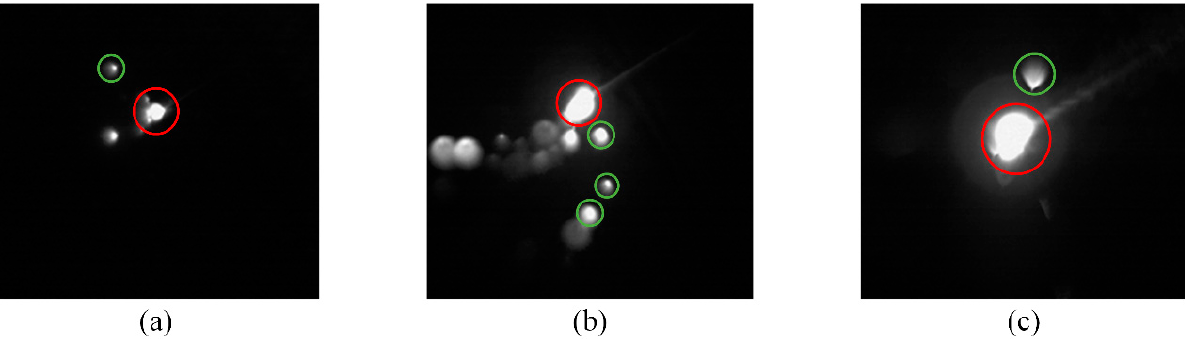
Figure 9. The collected typical spatter images with diffirent laser powers: ( a ) 50 W, ( b ) 100 W, and ( c ) 225 W. Molten pool is marked by the red circle while spatter is marked by green circles.